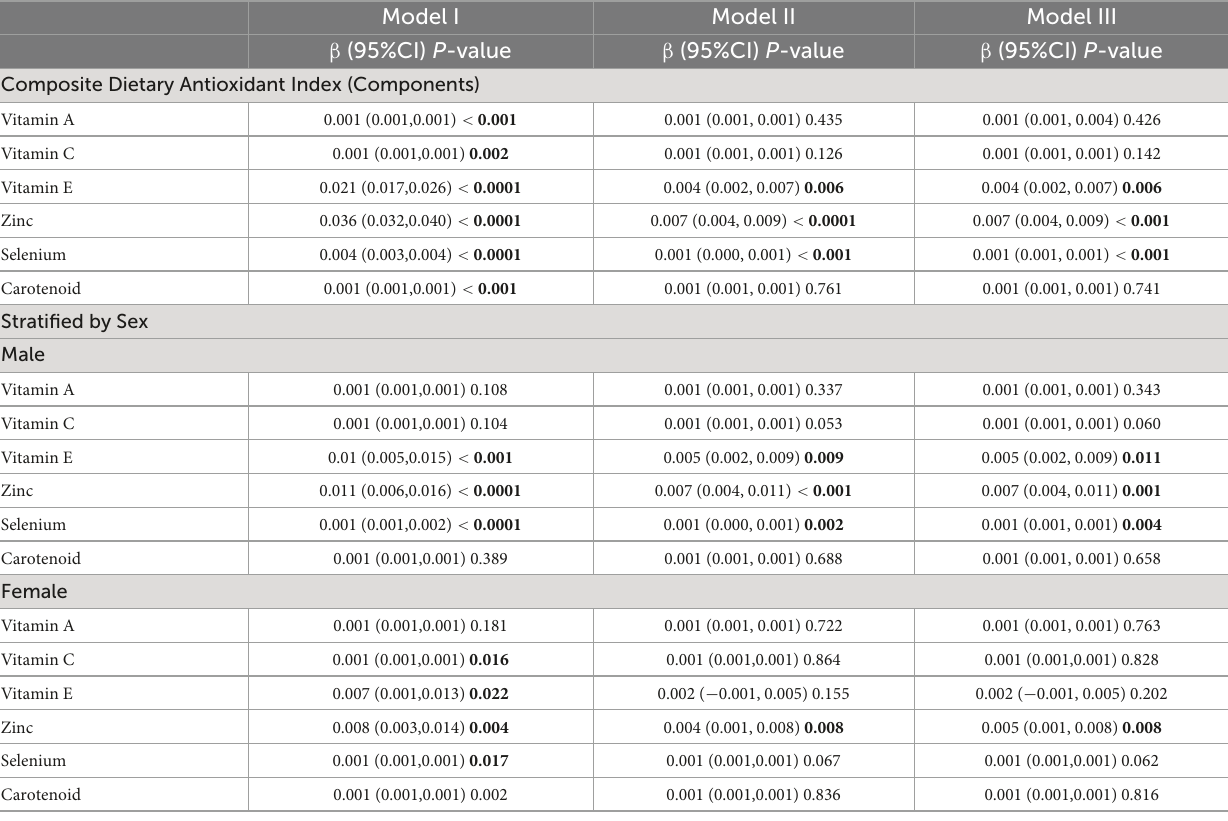
TABLE 3 The association between composite dietary antioxidant index (Components) and handgrip